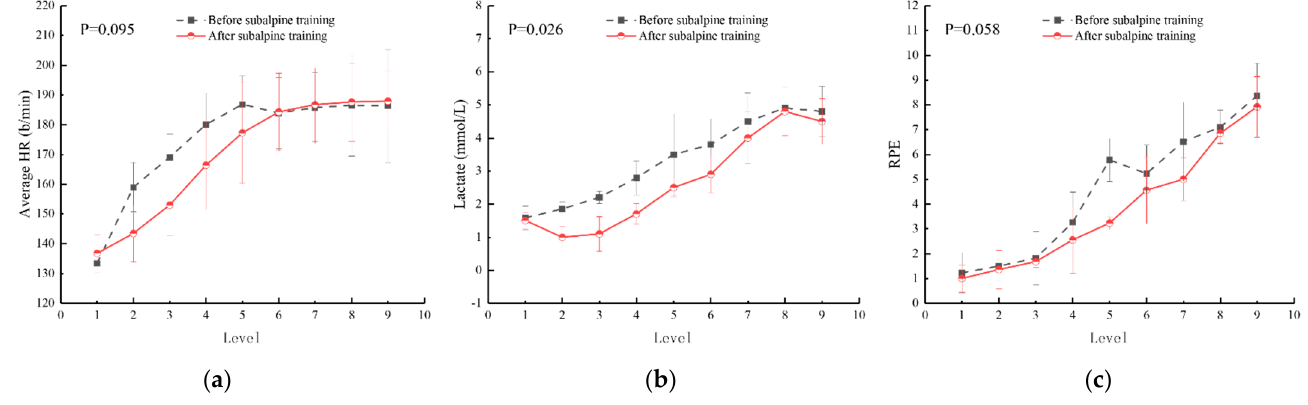
Table 8. Indicators related to the specific ability of female athletes.